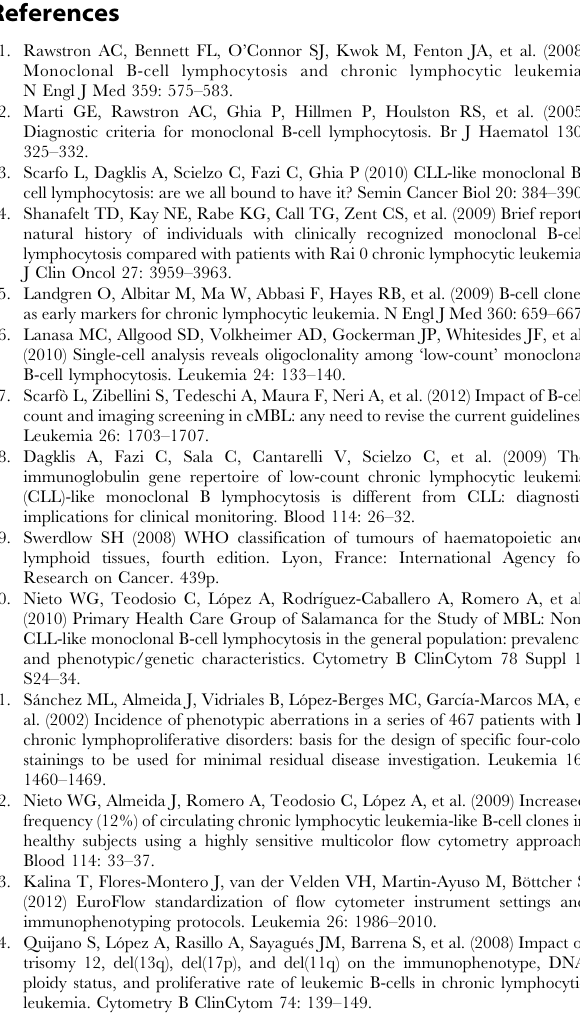
Table S1 Monoclonal antibody combinations used for the immunophenotypic analysis of CLL-like and CLL B cells. Table S2 Informative parameters of the CLL-like/CLL B-cell clones included in the three major groups graphically visualized with APS view of the Infinicyt TM software. Table S3 Heavy chain variable region (IGHV) sequences of CLL-like and CLL B-cell clones analyzed by the IMGT-V- QUEST